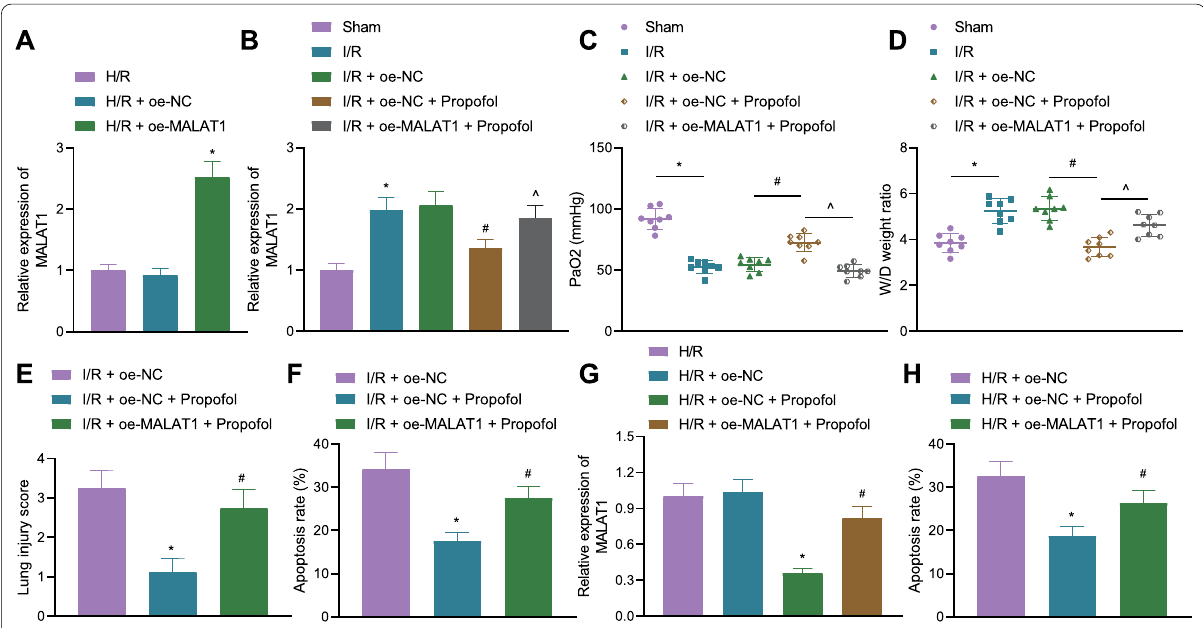
Fig. 2 Overexpressing MALAT1 curtails alleviating effects of Propofol. A MALAT1 overexpression efficiency in cells as detected by RT‑qPCR (* p < 0.05, compared with the oe‑NC group). B MALAT1 overexpression efficiency in mice as detected by RT‑qPCR (8 mice in each group; * p < 0.05, compared with that of the sham group; # p < 0.05, compared with the I/R oe‑NC group; $ p < 0.05 compared with the I/R oe‑NC Propofol group). C PaO 2 + + + level in mice (8 mice in each group; * p < 0.05, compared with that of the sham group; # p < 0.05, compared with the I/R oe‑NC group; $ p < 0.05 + compared with the I/R oe‑NC Propofol group). D W/D ratio in lung tissues of mice (8 mice in each group; * p < 0.05, compared with that of the + + sham group; # p < 0.05, compared with the I/R oe‑NC group; $ p < 0.05 compared with the I/R oe‑NC Propofol group). E Pathological changes of + + + lung tissues of mice as detected by H&E staining (8 mice each group; * p < 0.05, compared with that of the I/R oe‑NC group; # p < 0.05, compared + with the I/R oe‑NC Propofol group). F Cell apoptosis in lung tissues as determined by TUNEL staining (8 mice each group; * p < 0.05, compared + + with that of the I/R oe‑NC group; # p < 0.05, compared with the I/R oe‑NC Propofol group). G Expression of MALAT1 in cells as measured by + + + RT‑qPCR (* p < 0.05, compared with that of the H/R oe‑NC group; # p < 0.05, compared with the H/R oe‑NC Propofol group). H Cell apoptosis + + + as determined by flow cytometry ( p < 0.05, compared with that of the H/R oe‑NC group; # p < 0.05, compared with the H/R oe‑NC Propofol + + + group). Cellular experiments were repeated 3 times